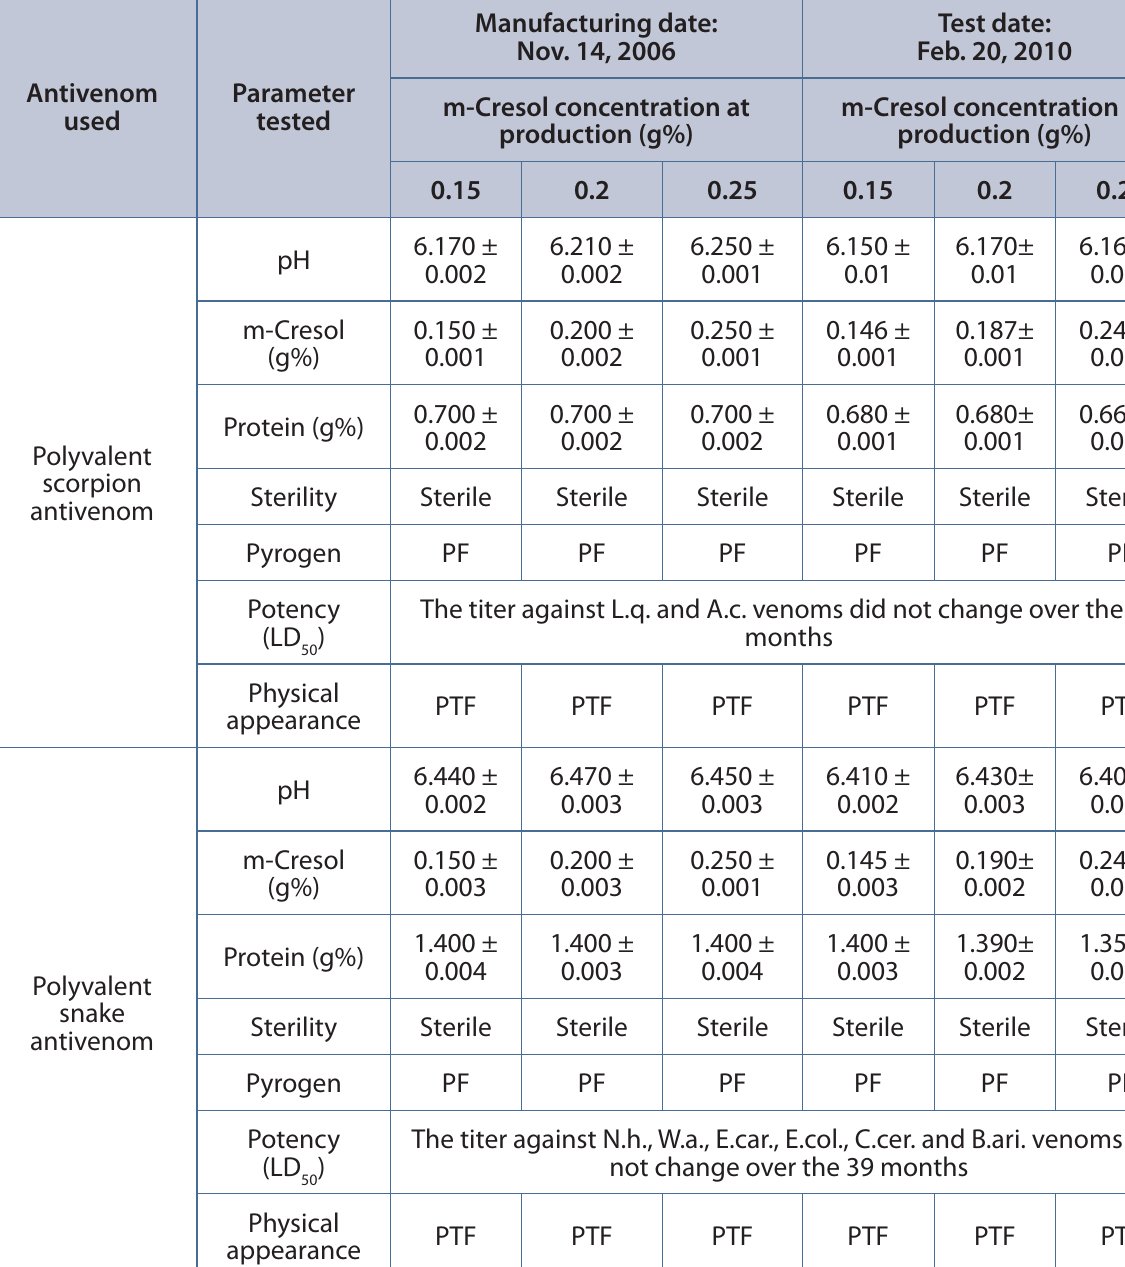
Table 6. Stability parameters of different antivenom products at the time of manufacturing and 39 months after their production